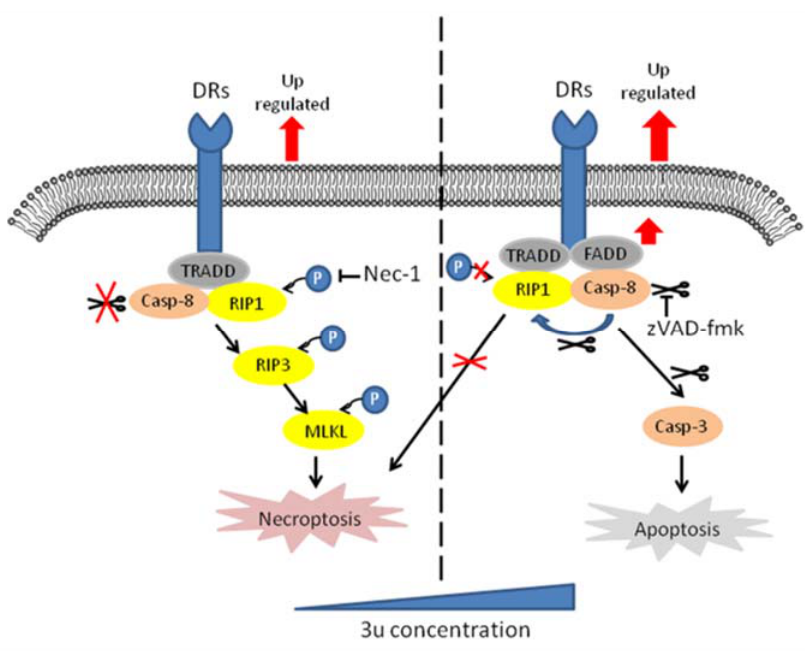
Figure 9. Mechanism of 3u-induced cell death in A375 cells. The model shows that 3u induces necroptosis at low concentrations and apoptosis at high concentrations in human melanoma A375 cells, and the activity of caspase-8 plays a key role in deciding the PCD type at high concentrations of 3u.